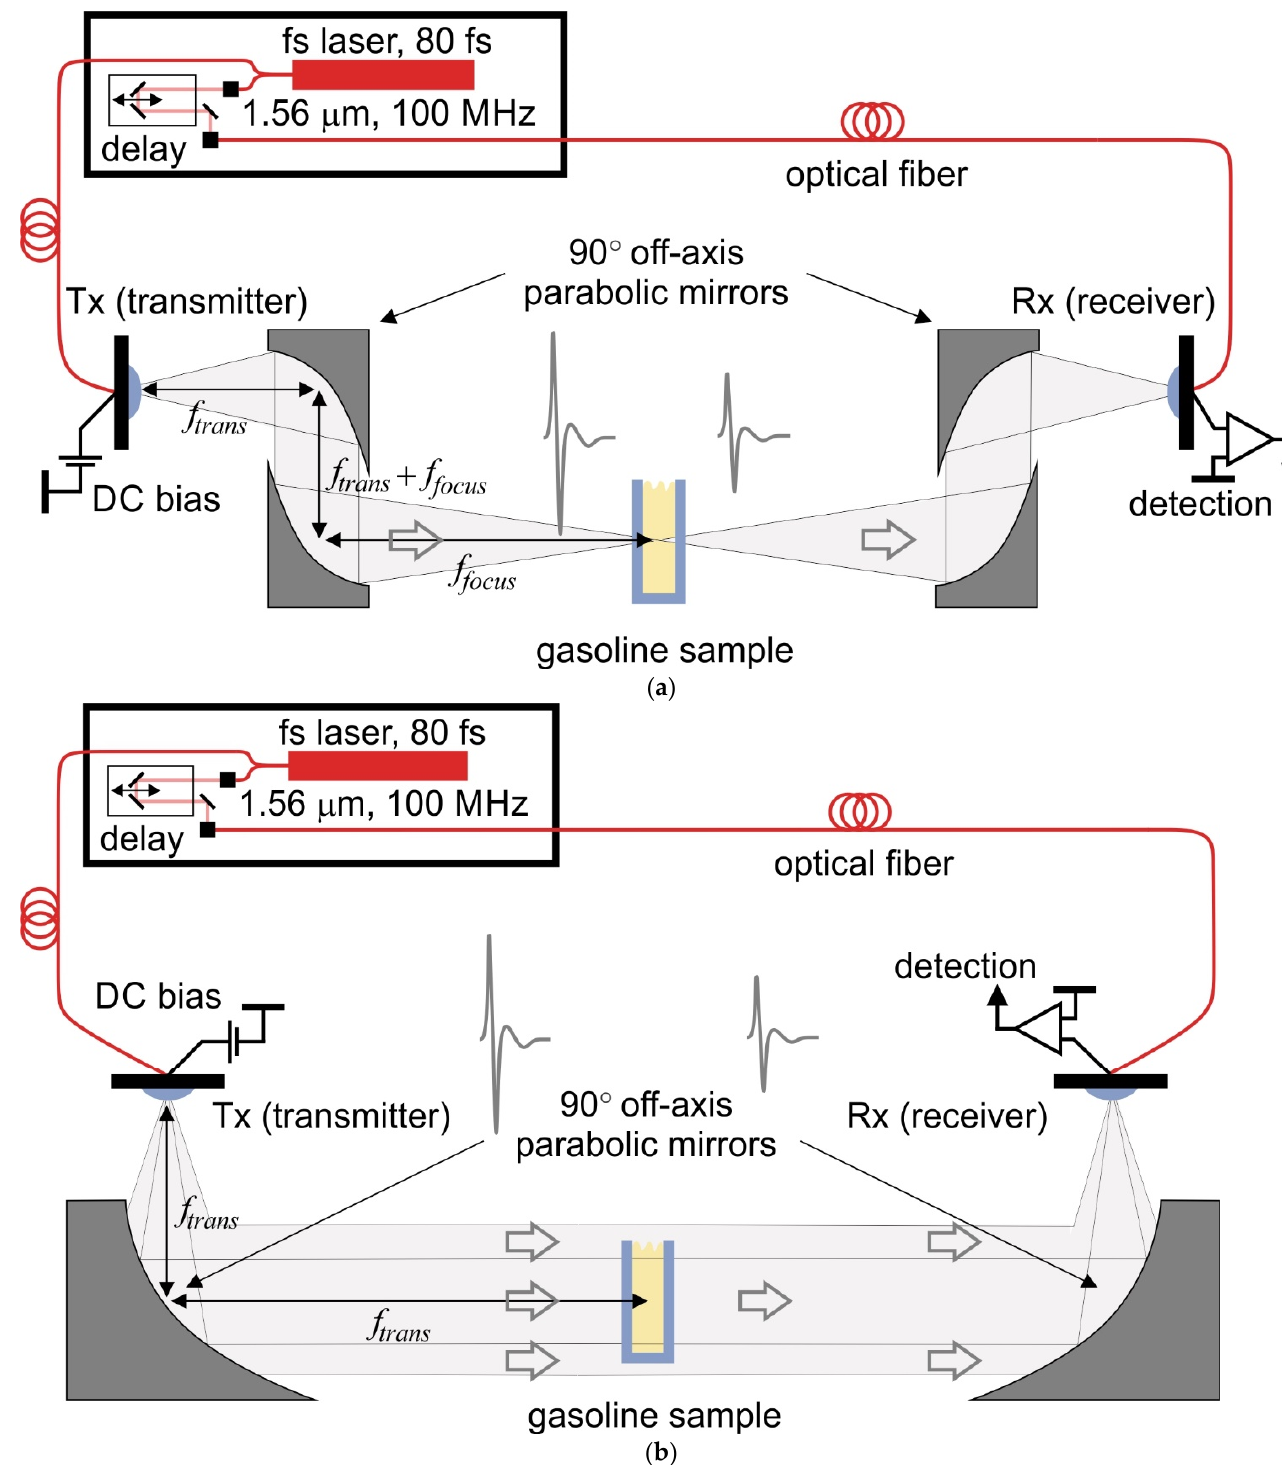
Figure 1. Schematic representation of the measurement setups: ( a ) 4f setup consisting of four 90° off-axis parabolic mirrors, which were used to measure THz pulse TOFs through the gasoline admixtures samples in quartz cuvettes of 1.00, 2.00, and 5.00 mm lengths in a focused beam configuration without a time-reference pulse; ( b ) 2f setup consisting of two 90° off-axis parabolic mirrors used for the measurements in a 10.00 mm-long TPX cuvette with a time-reference pulse. Note that the diameter of the THz beam is somewhat larger than the size of the cuvette and passes freely through the inert gas, serving as a reference for the measured TOF. The indicated focal lengths are not to scale.